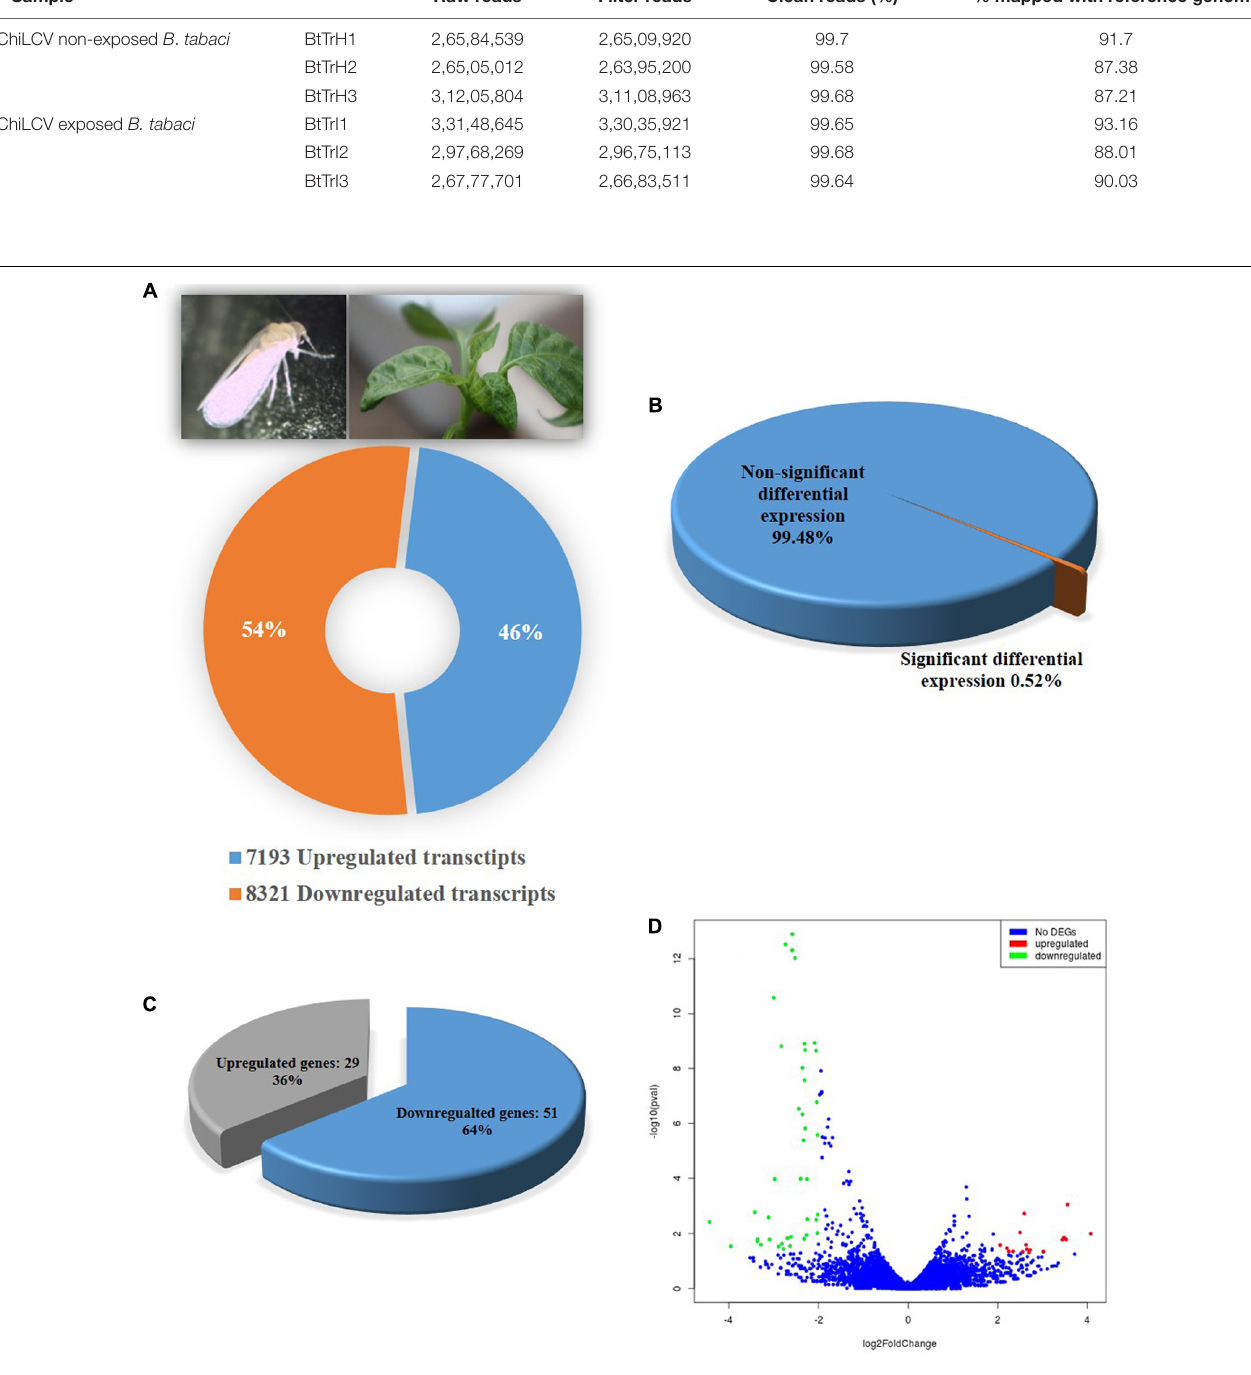
Frontiers in Microbiology |